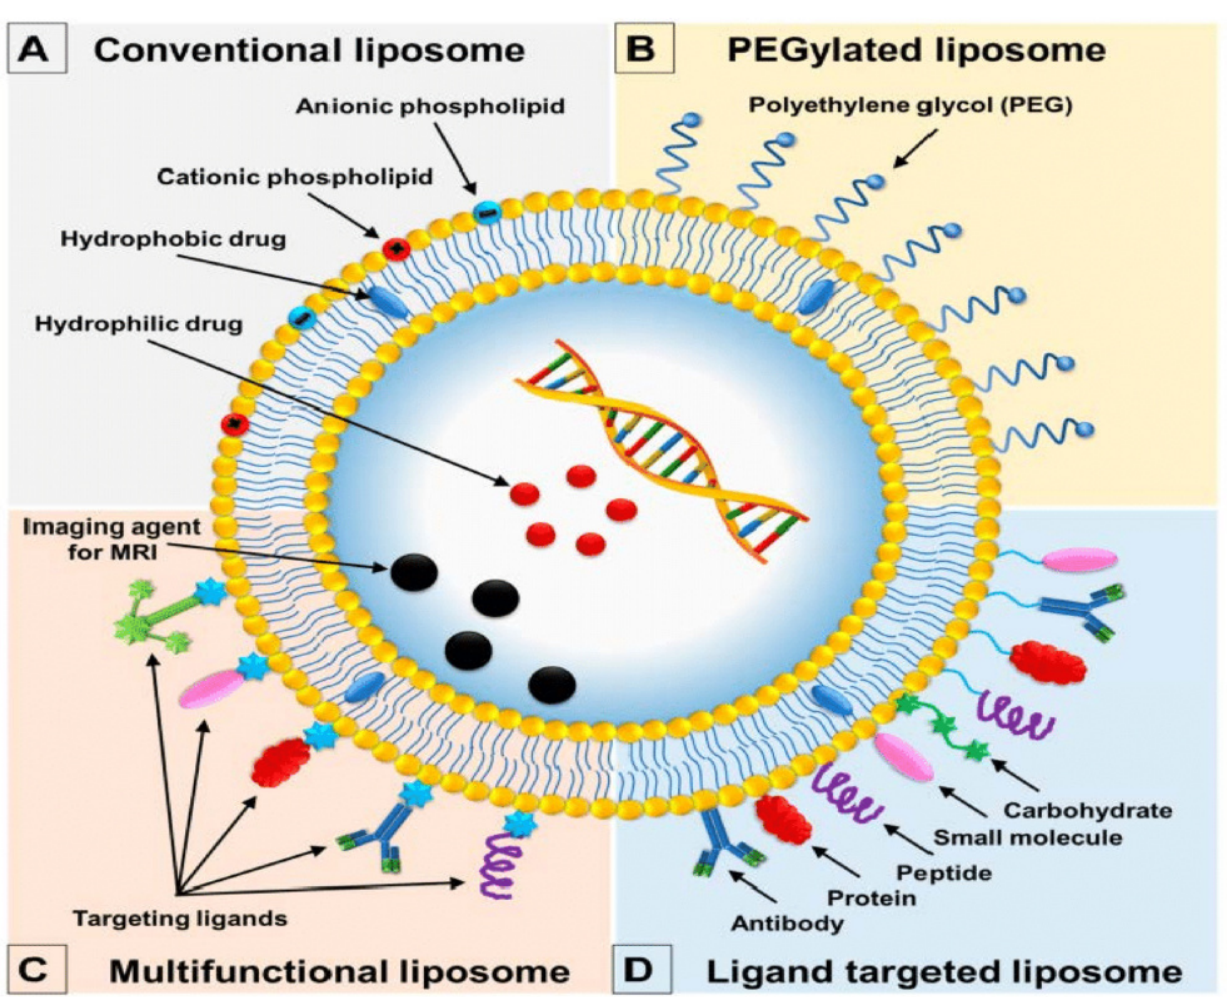
Figure 10. Classification of liposomes by surface modification strategies: conventional liposomes ( A ), PEGylated liposomes ( B ), multifunctional liposomes ( C ), and ligand-targeted liposomes ( D ). Reprinted with permission from [192]; copyright (2022). International Journal of Applied